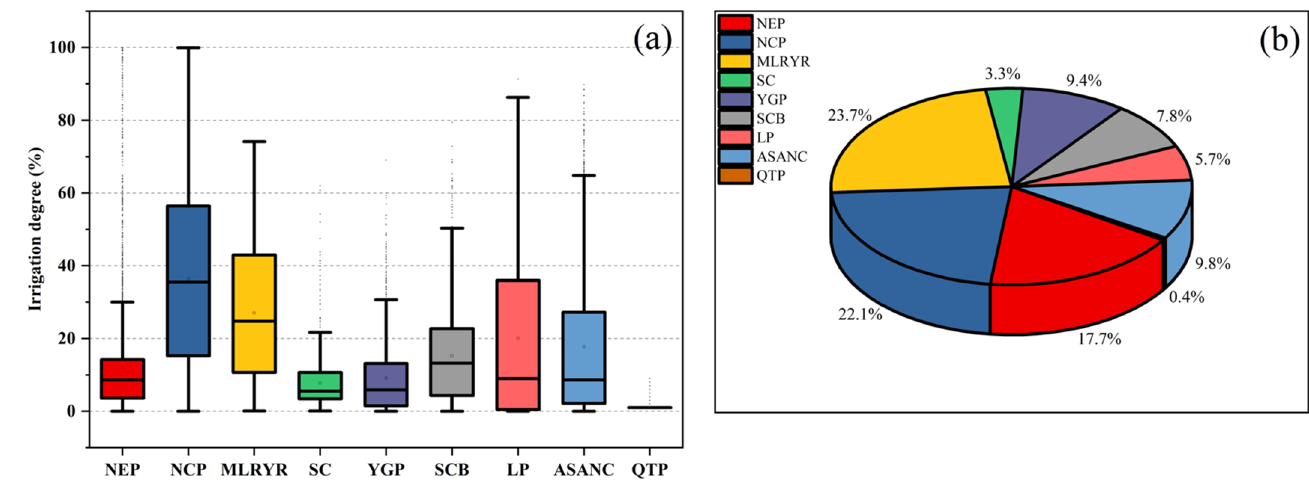
Figure 3. Numerical distribution of irrigation degree ( a ) and percentage of cropland areas ( b ) in different major crop-producing areas of China.